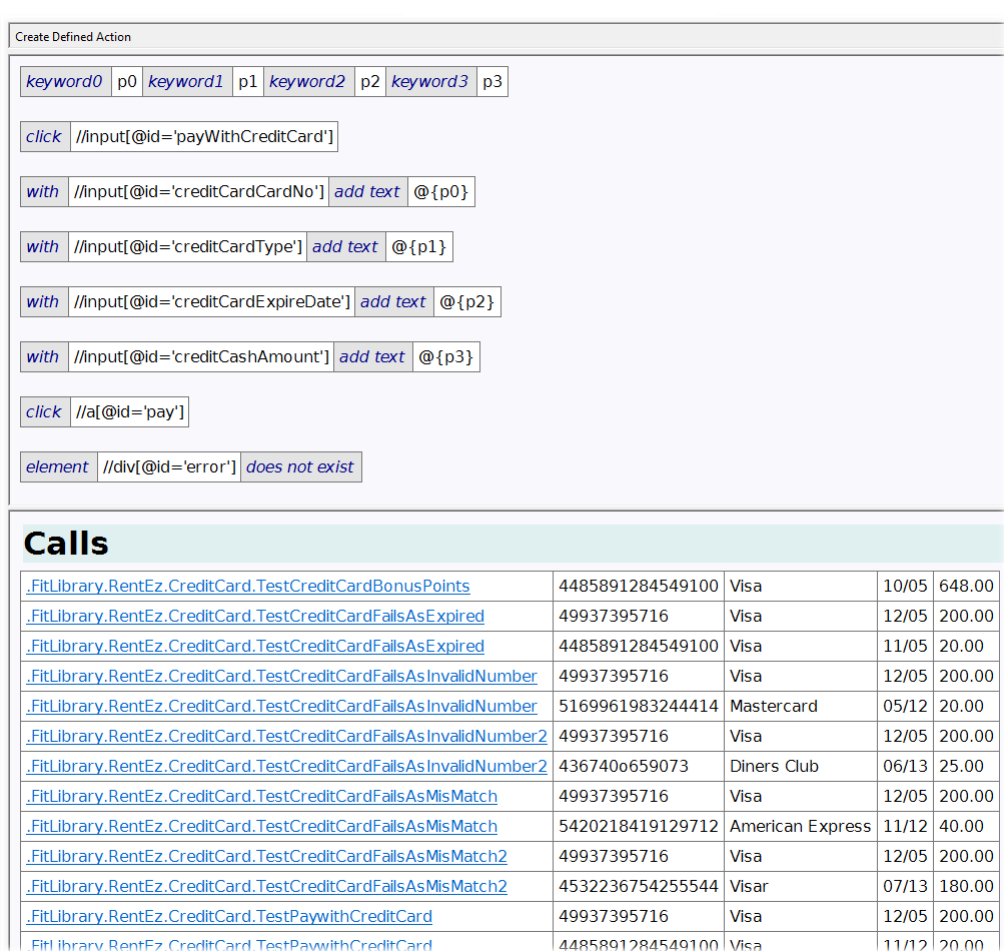
Figure 4. A possible